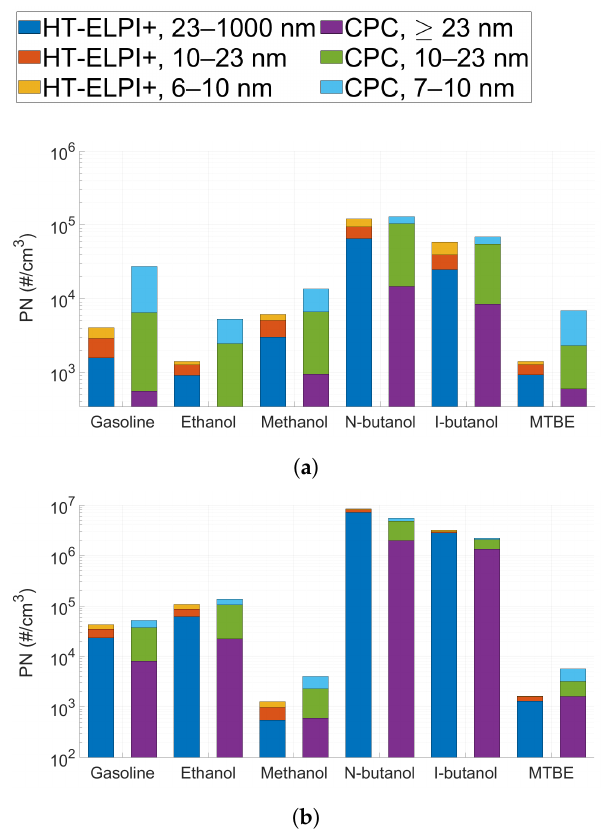
Figure 9. A comparison of the total number and particle size distribution between the undiluted (HT-ELPI+) and the diluted (CPC) particle number measurements at ( a ) 3500 RPM and 7.5 bar IMEP and ( b ) 1500 RPM and 13 bar